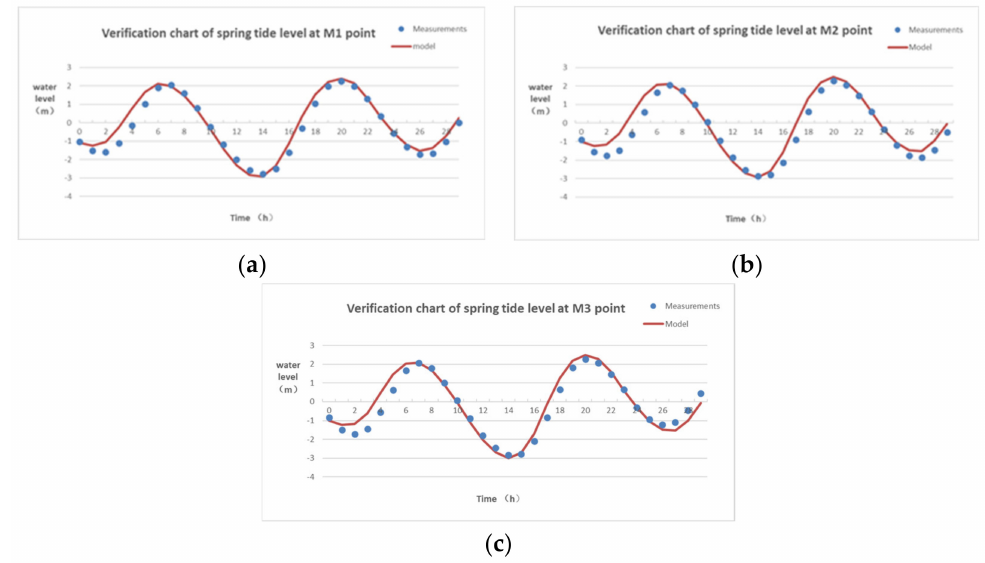
Figure 4. Tide level verification in 2006. ( a ) Verification chart of spring tide level at Point M1; ( b ) Verification chart of spring tide level at Point M2; ( c ) Verification chart of spring tide level at Point M3.